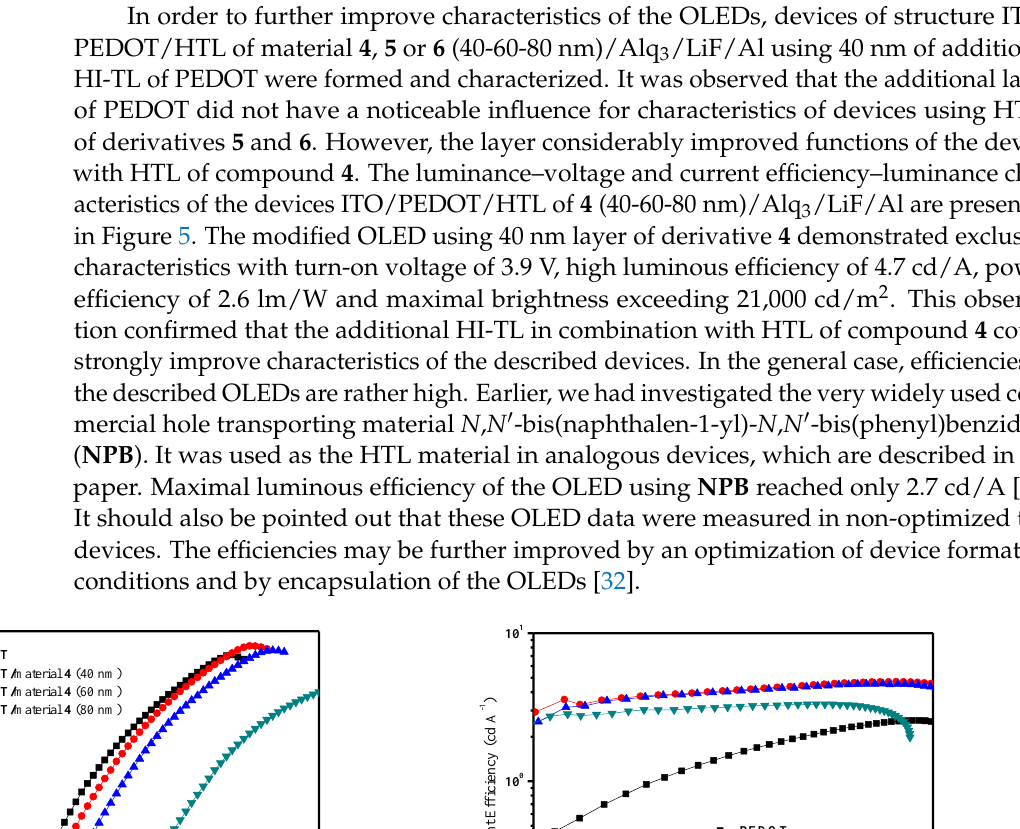
efficiency of 2.6 lm/W and maximal brightness exceeding 11,670 cd/m 2 . The HTL of 6 based device also showed exclusive OLED characteristics. The device was characterized by turn-on voltage of 3.4 V, maximum brightness of 13,193 cd/m 2, luminous efficiency of 3.8 cd/A and power efficiency of 2.6 lm/W. An additional hole injecting – transporting layer of PEDOT considerably improved functions of the device with the HTL of compound 4 . The modified OLED using layer of derivative 4 demonstrated exclusive characteristics with turn-on voltage of 3.9 V, high luminous efficiency of 4.7 cd/A, power efficiency of 2.6 lm/W and maximal brightness exceeding 21,000 cd/m 2 . These observations confirmed that the tested HTL materials have big potential in the field of optoelectronics. 3. Materials 9 H -Carbazole ( 1 ), 3,3-bis(chloromethyl)oxetane, 4-fluorophenylboronic acid, phenyl- boronic acid, naphthalene-1-boronic acid, bis(triphenylphosphine)palladium(II) dichlo- ride (Pd(PPh 3 ) 2 Cl 2 ), K 2 CO 3 , KOH, KI, KIO 3 , tetra- n -butylammonium hydrogen sulfate (TBAHS) and Na 2 SO 4 were purchased from Merck and used as received. In addition, 3-Iodo-9 H -carbazole ( 2 ) was synthesized according to the procedure de- scribed in the literature [29]. Preparation of 3,3-Di[3-iodocarbazol-9-yl]methyloxetane ( 3 ) was performed accord- ing to the same method, which we have described earlier [33]. Then, 3,3-Di[3-(4-flourophenyl)carbazol-9-yl]methyloxetane ( 4 ), 0.4 g (0.6 mmol) of 3,3-di [3-iodocarbazol-9-yl]methyloxetane ( 3 ), 0.21 g (1.5 mmol) of 4-fluorophenylboronic acid, 0.02 g (0.03 mmol) of PdCl 2 (PPh 3 ) 2 and 0.17 g (3.0 mmol) of powdered KOH were stirred in 8 mL of THF containing degassed water (1 mL) at 80 °C under nitrogen for 24 h. After TLC control, the reaction mixture was cooled and quenched by the addition of ice water. The product was extracted with chloroform. The combined extract was dried over anhydrous Na 2 SO 4 . The crude product was purified by silica gel column chromatography